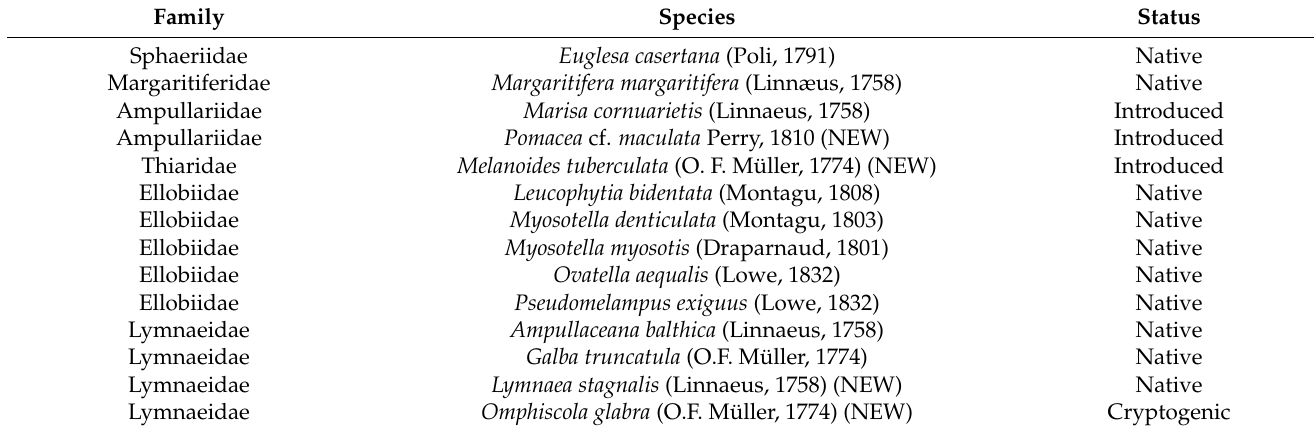
Table A1. Diversity of freshwater molluscs of the Principality of Asturias. NEW: New record. ‘ ? ’: needs confirmation.